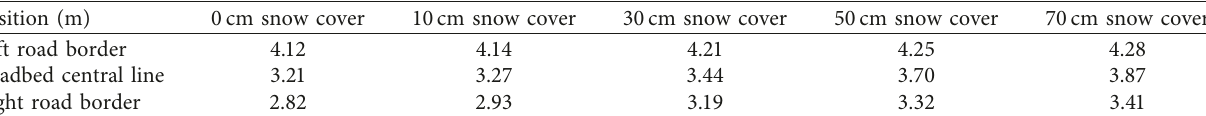
Figure 11: The frozen soil upper limit under the roadbed on October 1 after 30years of roadbed operation. Table 4: Frozen soil upper limit of roadbed under different thickness of snow